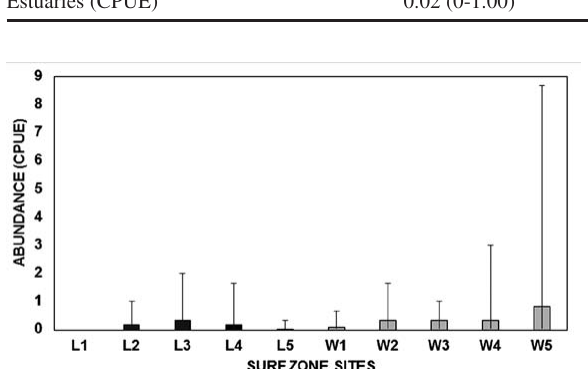
Fig. 3. – Solea turbynei occurrence at leeward and windward sites along the Algoa Bay coastline, South Africa (leeward sites L1-5 and windward sites W1-5 are shown in Fig. 1).